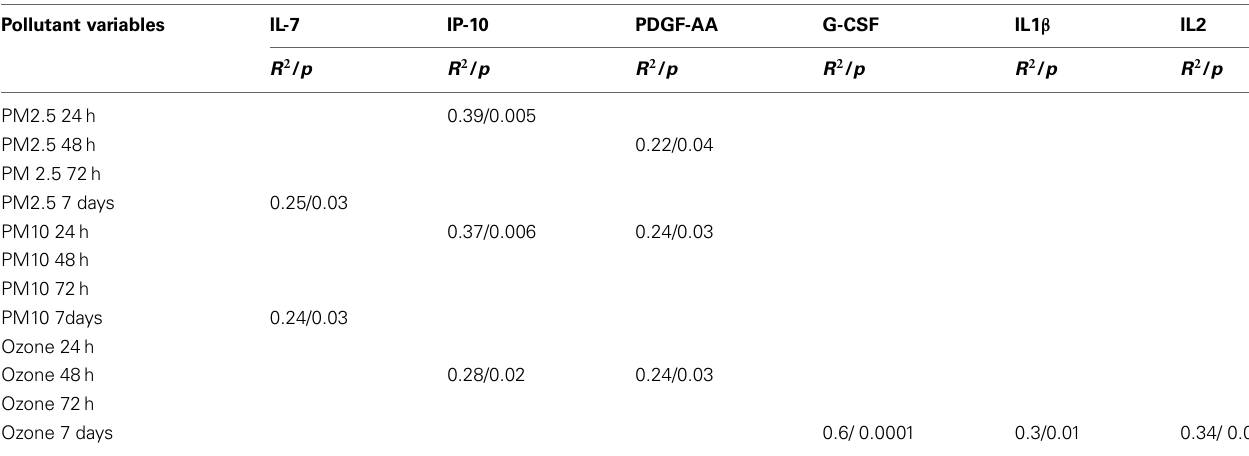
Table 5 | Statistically significant post-cocoa intervention differences in selected cytokines and chemokines variables associated with PM and ozone cumulative values.